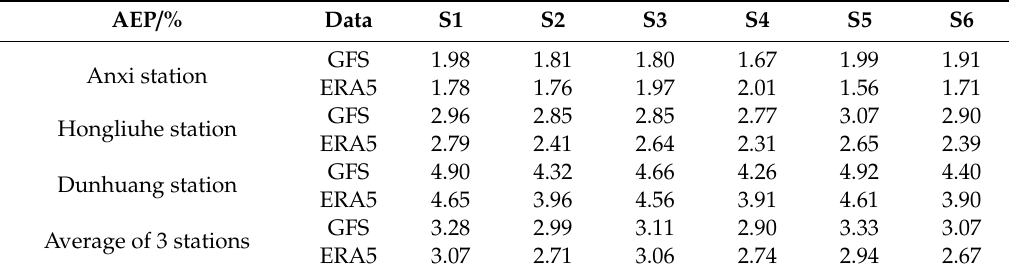
Table 5. Average Rs of T2 for different combinations of initial data and parameterization schemes. R S1 S2 S3 S4 S5 S6 GFS Note: * trend significant at a = 0.01. Table 6. Average AEPs at different stations and AEPs averaged at three stations under different combinations of initial data and parameterization schemes. AEP/% Data